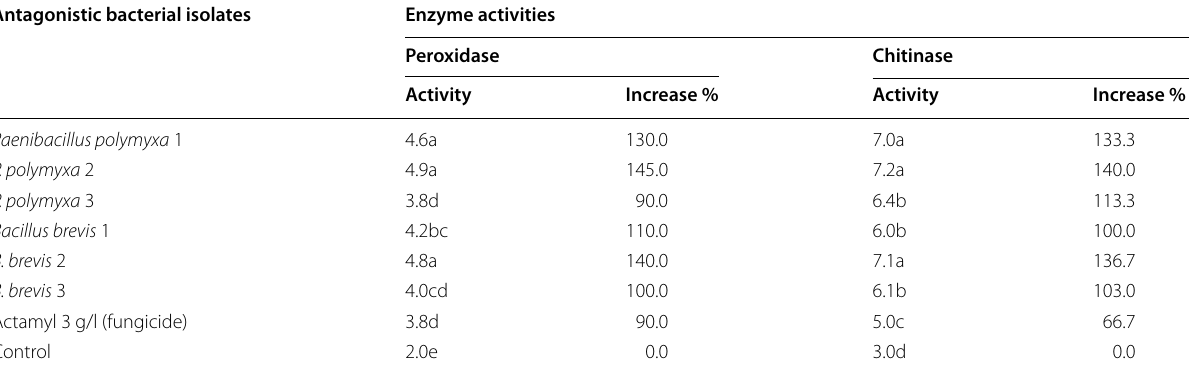
*Means in a column followed by the same letter are not significantly ( P